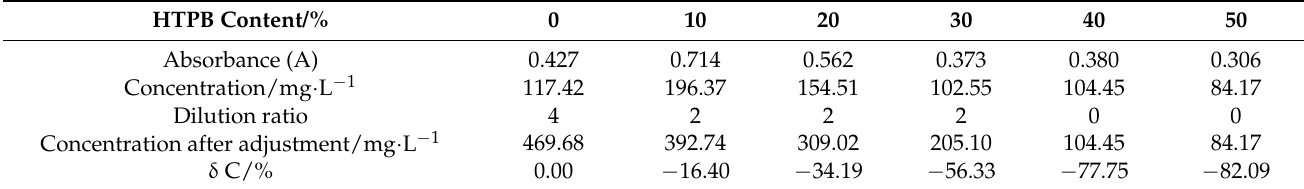
Figure 6. UV results of the residual dye: ( a ) after the first wash; ( b ) after the second wash; ( c ) after the third wash. Table 9. Concentration of residual dye after the third wash.